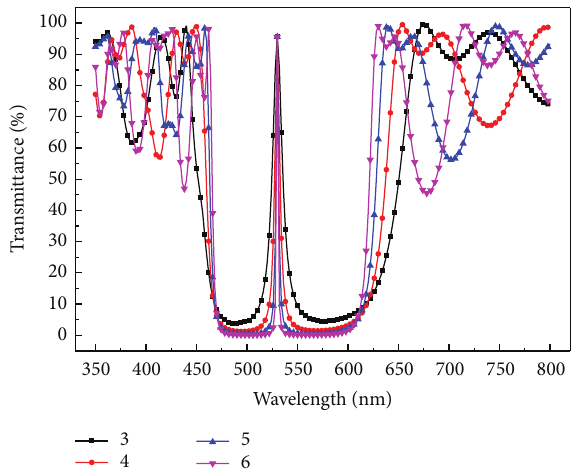
Figure 4: Transmitted spectrum of one-dimensional photonic crystal with different periods.